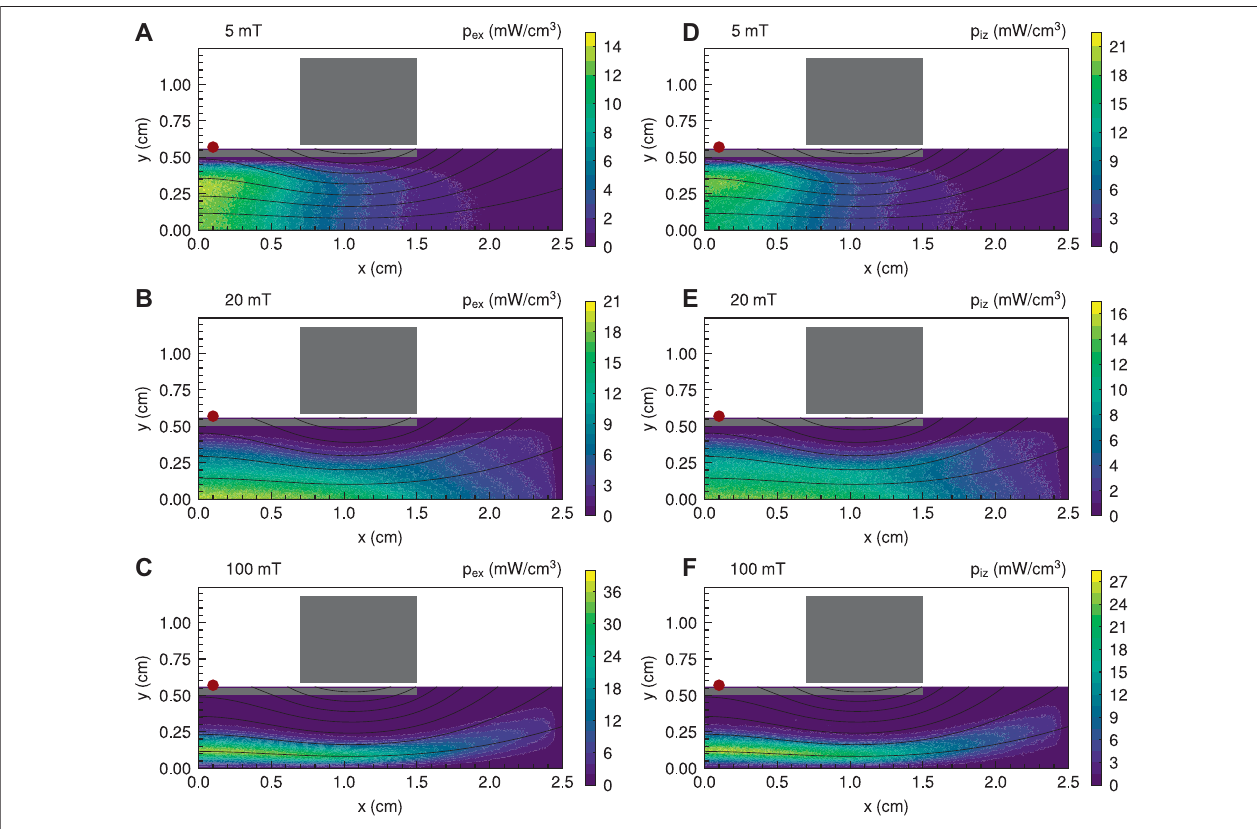
FIGURE11| x - y pro fi lesoftheexcitationenergylossdensity p ex forthethreemagnetic fi eldstrengthsof (A) 5, (B) 20,and (C) 100 mTandtheionizationenergyloss density p iz for the three magnetic fi eld strengths of (D) 5, (E) 20, and (F) 100 mT. Solid black lines show magnetic fi eld lines.